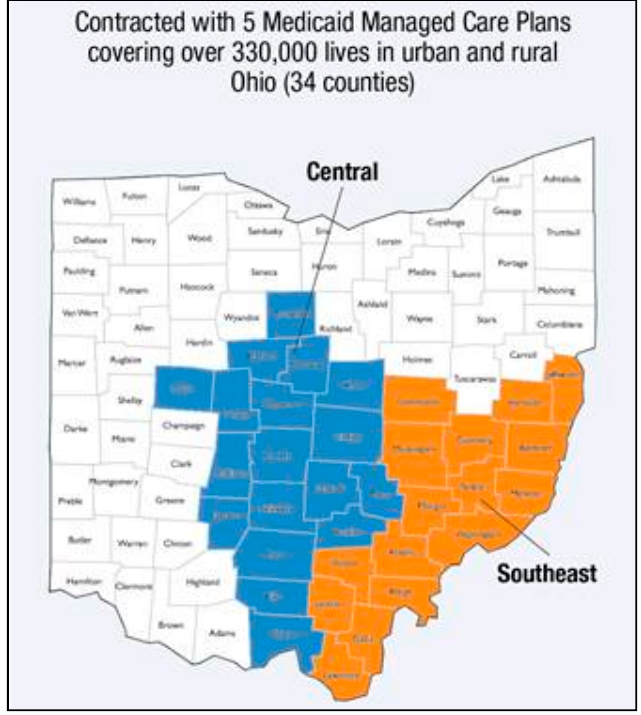
Figure 2. Map of Ohio with the highlighted region indicating which county Partners For Kids (PFK) patients live.